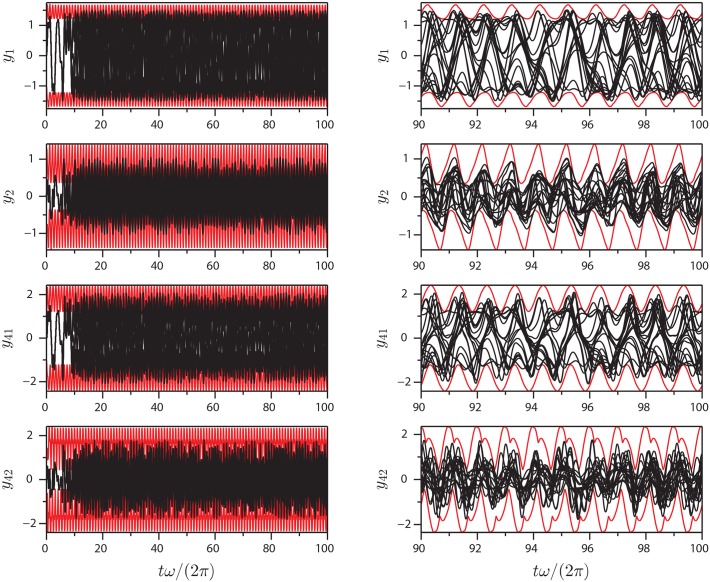
Extrema of Eq (12): Plots of extrema (red) and 20 different time series (black) of variables y1, y2, y41 and y42 for parameter set II.